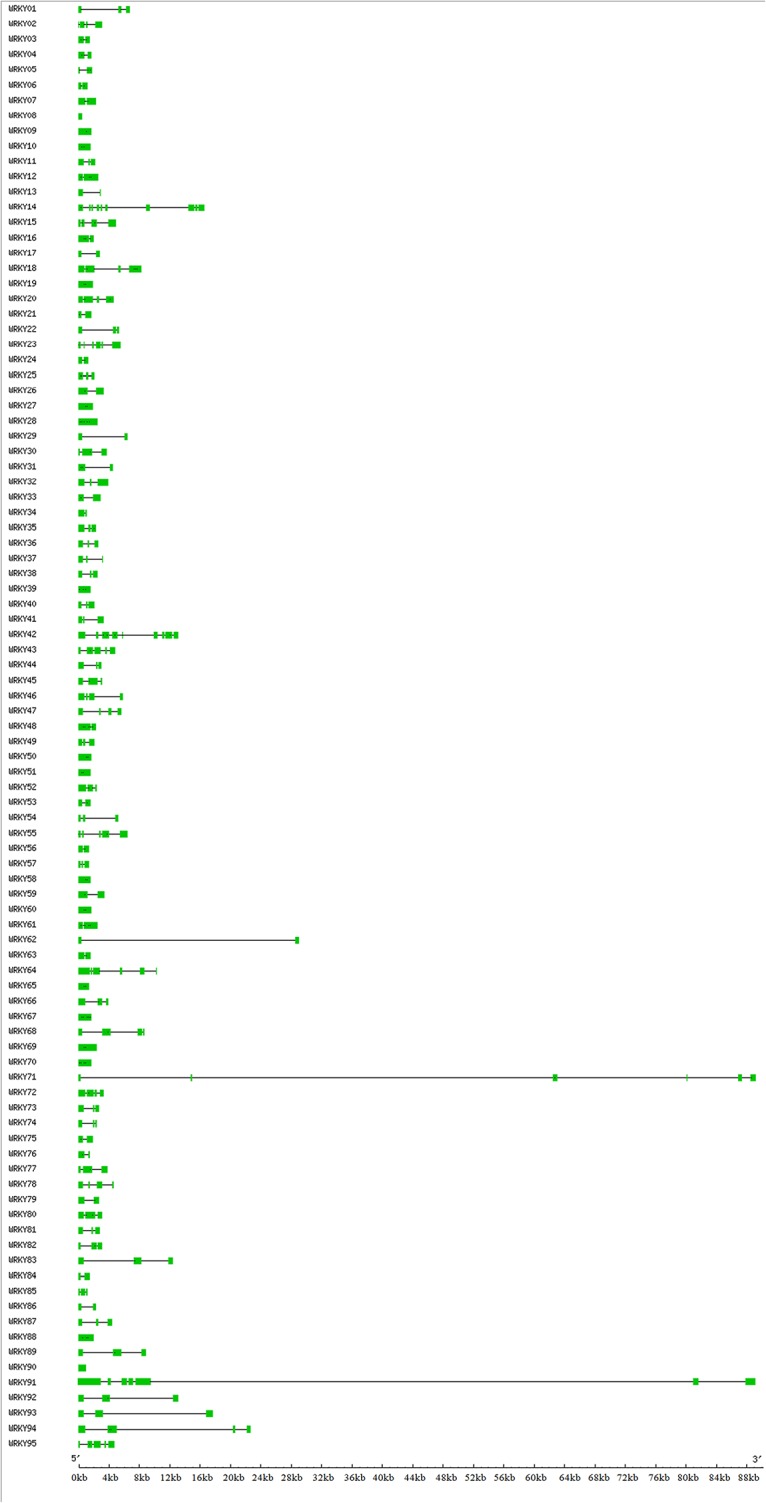
Gene structures of the 95 EgWRKY genes identified in this study.Exons are represented by coloured boxes and introns are represented by black lines.